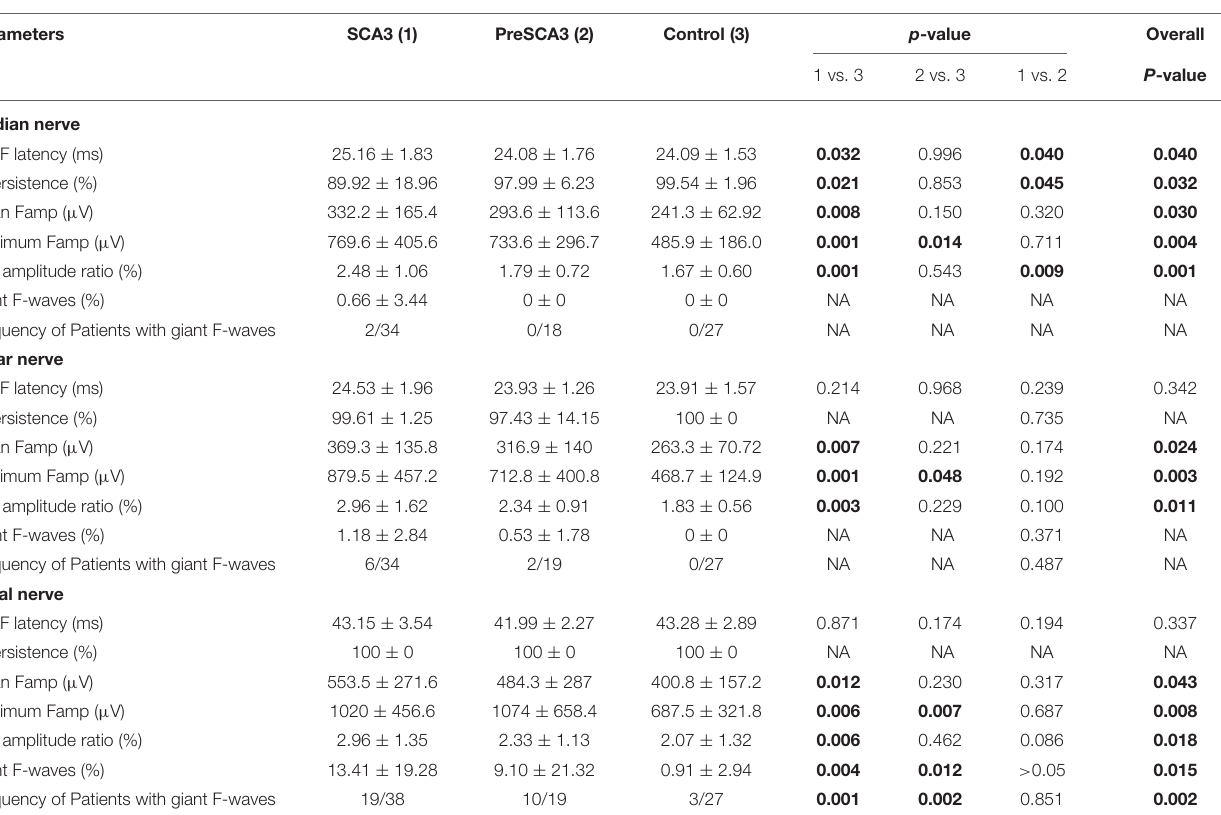
TABLE 3 | F-wave studies in upper and lower extremity